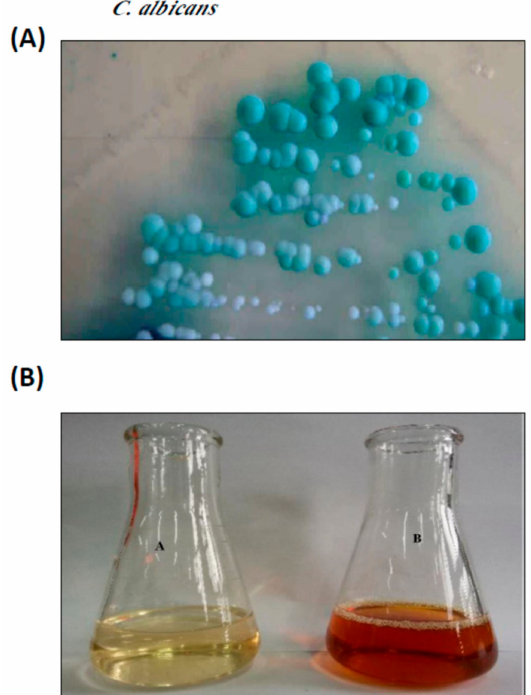
Figure 1. Synthesis of AgNPs from the leaf extract of Calotropis gigantean (CG). ( A ) Candida albicans isolated from sputum samples, cultured on Sabouraud’s dextrose agar (SDA). ( B ) Silver nitrate solution before (A) and after (B) the synthesis of AgNPs from the leaf extract of C.